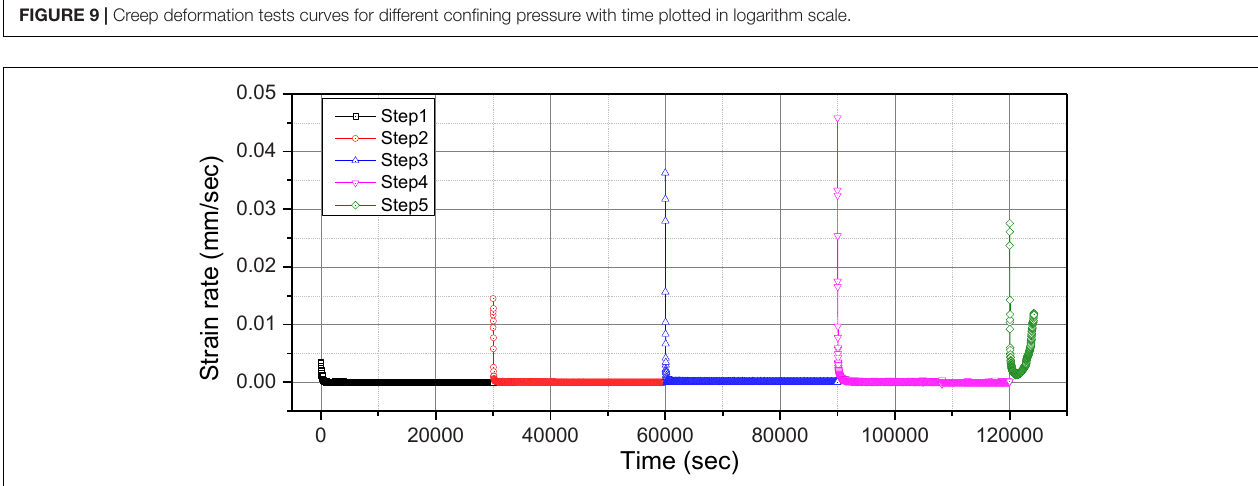
FIGURE 10 | Creep deformation development rates (for the sample tested at the confining stress of 75 kPa).